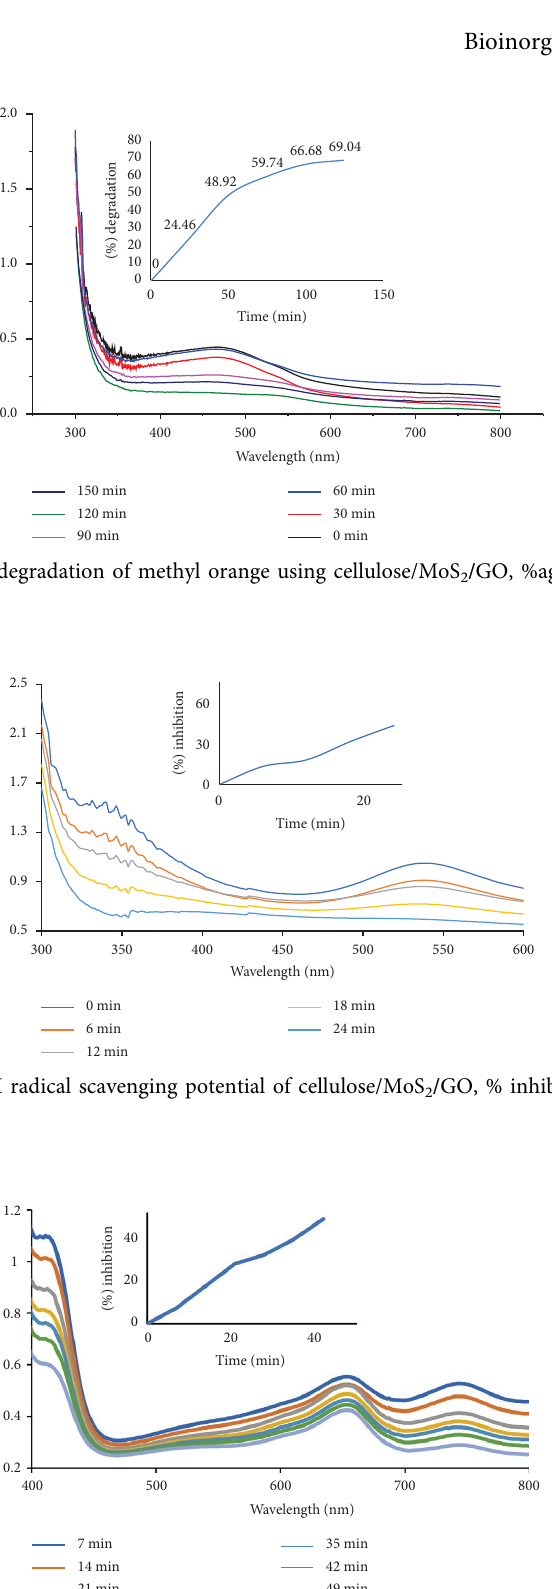
2 / GO, % inhibition (inset).